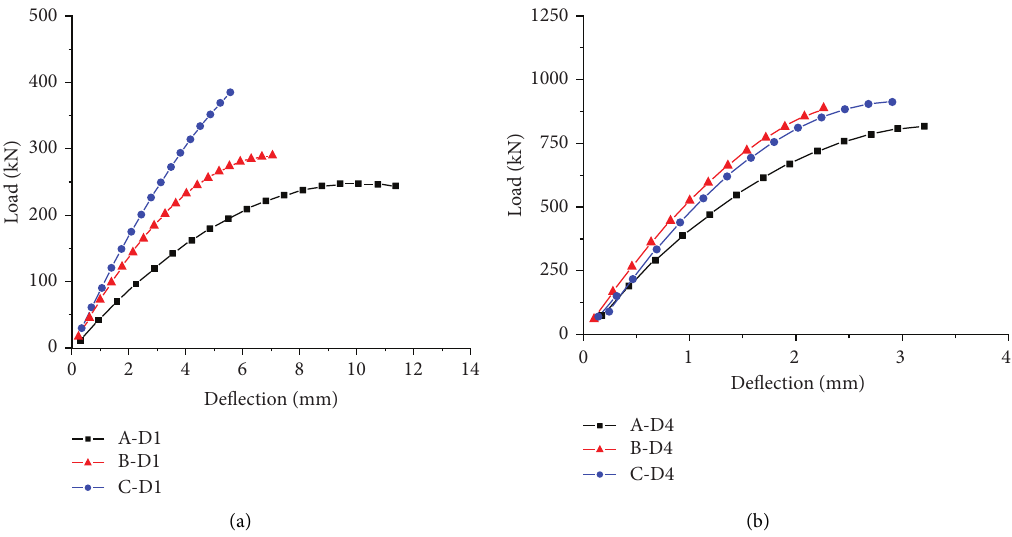
Figure 9: Influence of longitudinal reinforcement ratio on the load-deflection